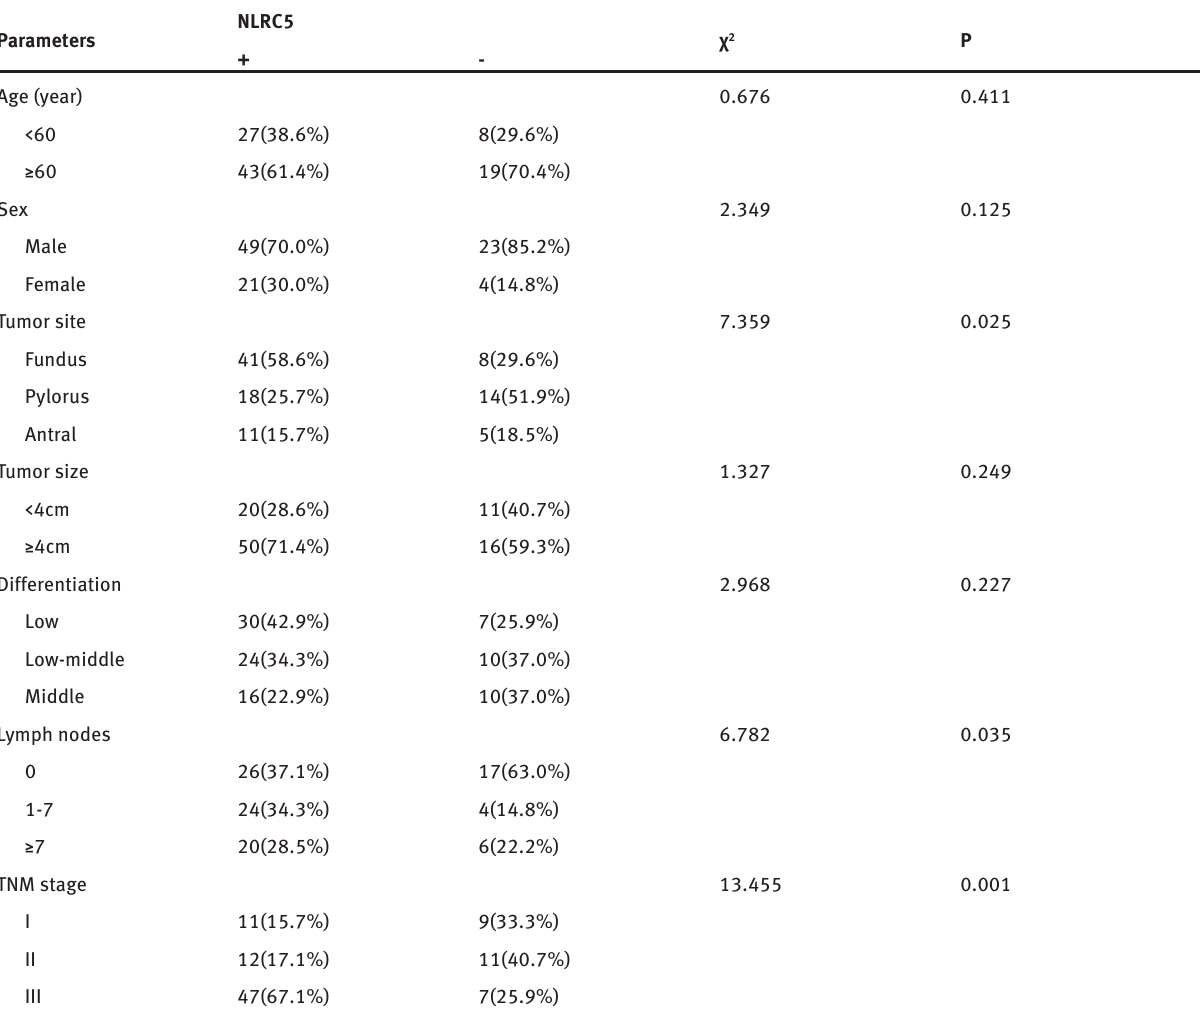
Table 1: Relationship between NLRC5 and clinicopathological characteristics in patients with gastric cancer